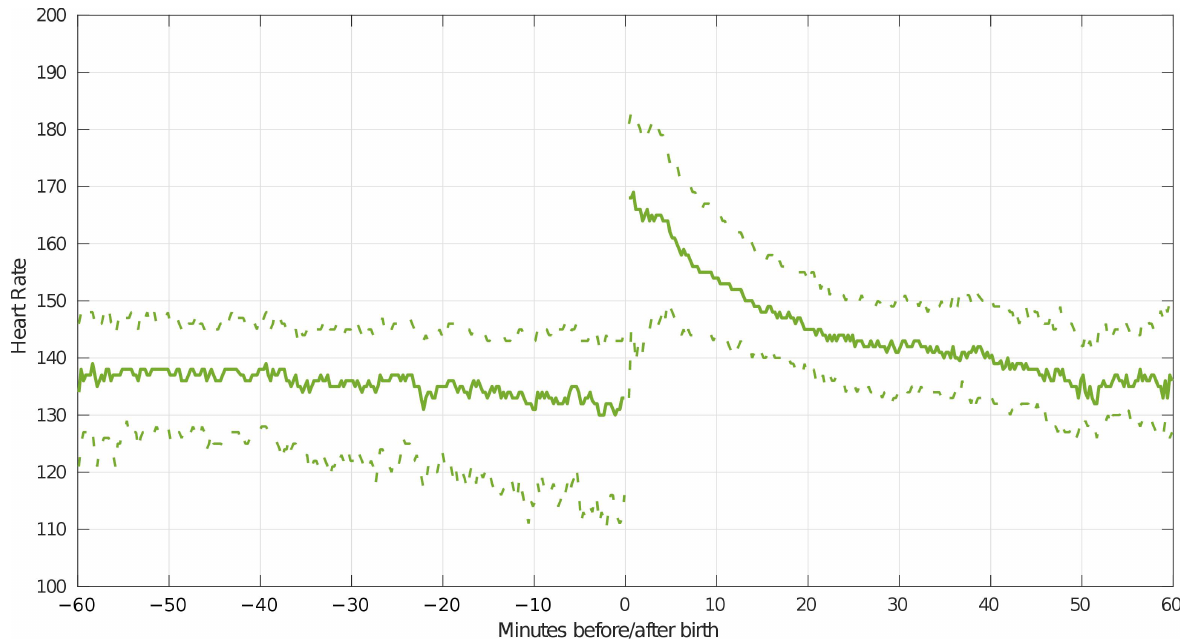
Figure 4. Illustration of heart rate transition from one hour before delivery to one hour after delivery. The solid line shows the median heart rate, and the dashed lines show the 25th and 75th percentiles. Each point on the curves indicates the median and percentile for a 15 s time